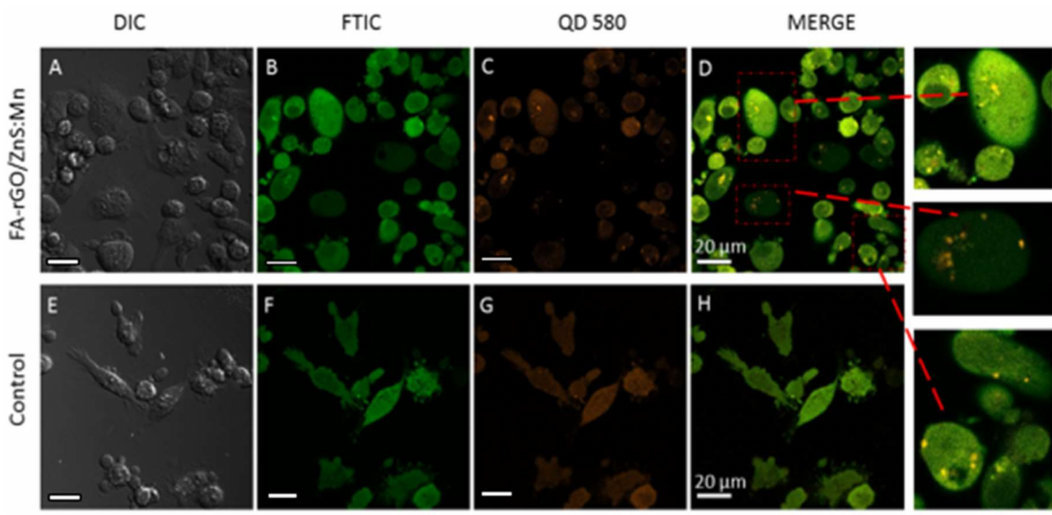
Figure 7. Bright-field (DIC), fluorescence (FTIC and QD 580) and merged microscopic images of MDA-MB 231 cells in the presence ( A – D ) and absence ( E – H ) of 100 µ g/mL FA-rGO/ZnS:Mn after incubation for 6 h. Scale bar = 20 µ